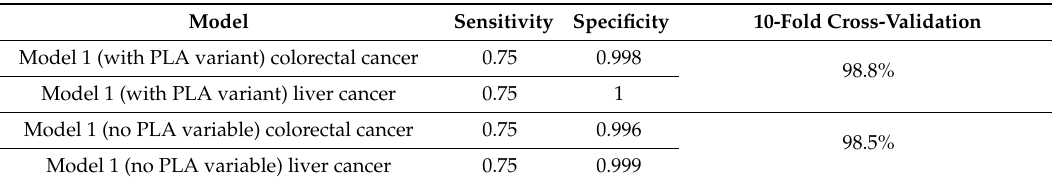
Table 13. Comparison of Model